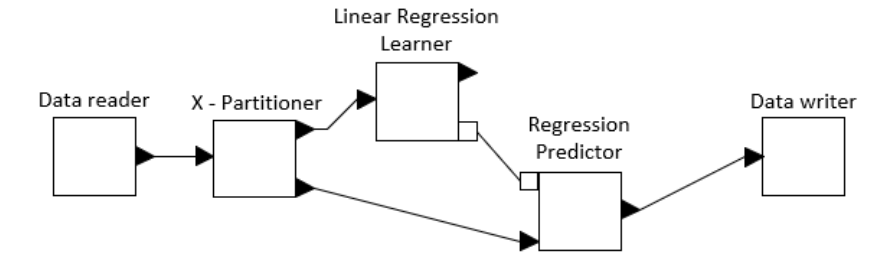
Figure 4. Diagram block of the linear predictor.